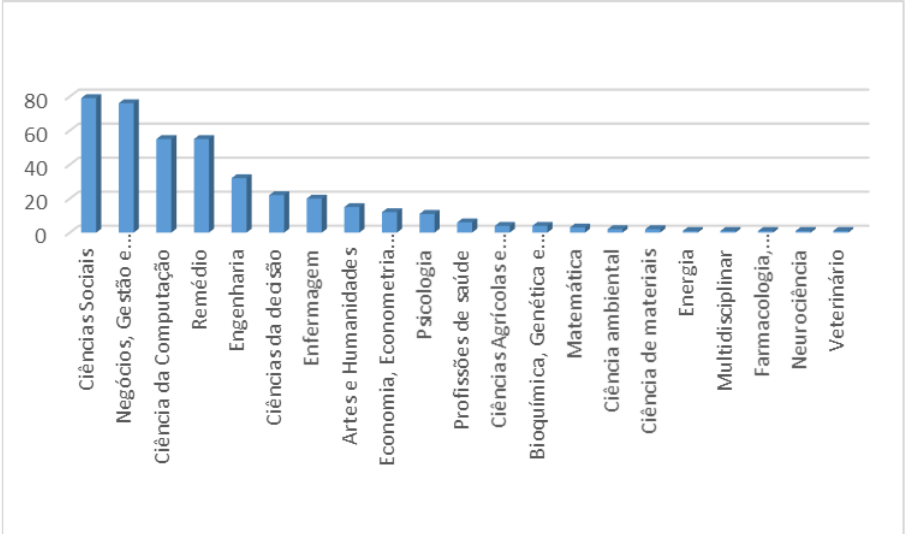
Figure 4. Areas of knowledge of the publication